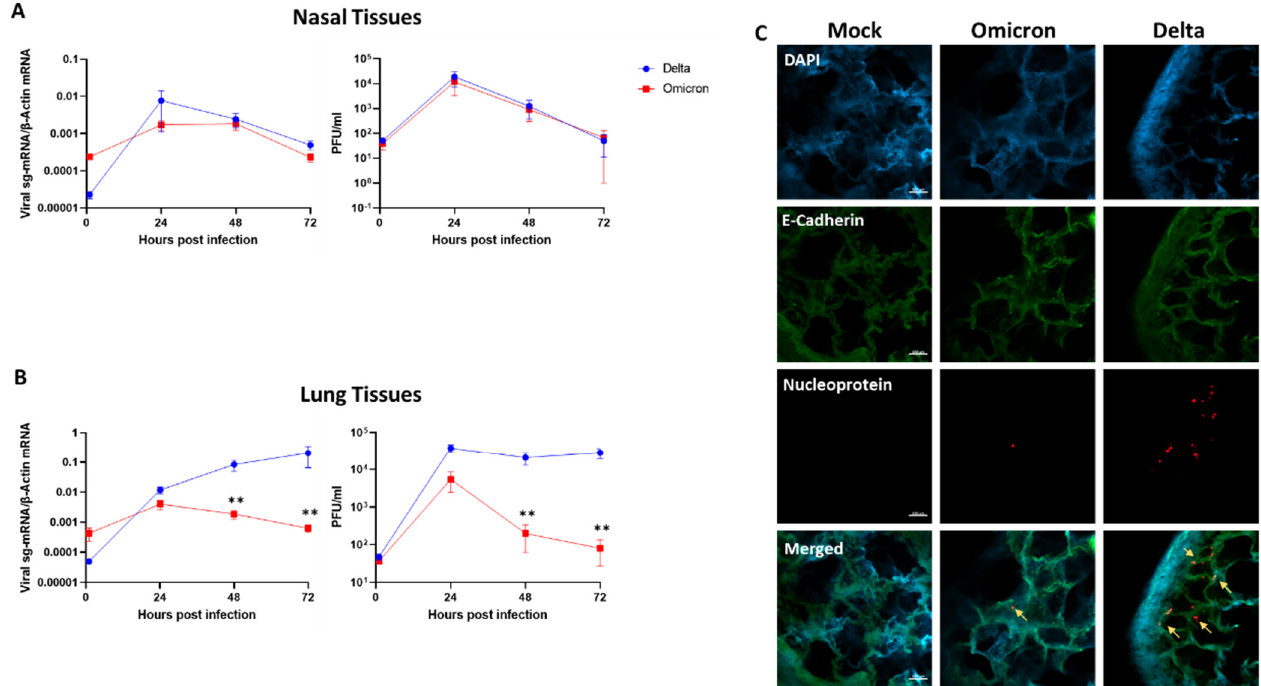
Figure 1. SARS-CoV-2 Omicron and Delta replication kinetics in human nasal and lung tissues. Nasal ( A ) and lung ( B ) organ cultures were (each) infected in parallel with Omicron and Delta (10 5 PFU/well). The levels of tissue-associated viral sub-genomic (sg)-mRNA (left panels) and infectious virus progeny released from the same infected tissues (right panels) represent mean values (±SEM) of four and five independent nasal and lung tissues, respectively, each tested in four biological replicates. ( C ) Representative confocal micrographs of whole-mount lung tissues at 72 h post-infection. Whole-mount tissues were visualized using a Nikon A1R confocal microscope and were analyzed using NIS Elements software (Nikon). Scale bar = 100 μ m. **, p < 0.01. Statistics were performed using multiple paired, two-tailed Student’s t -test.